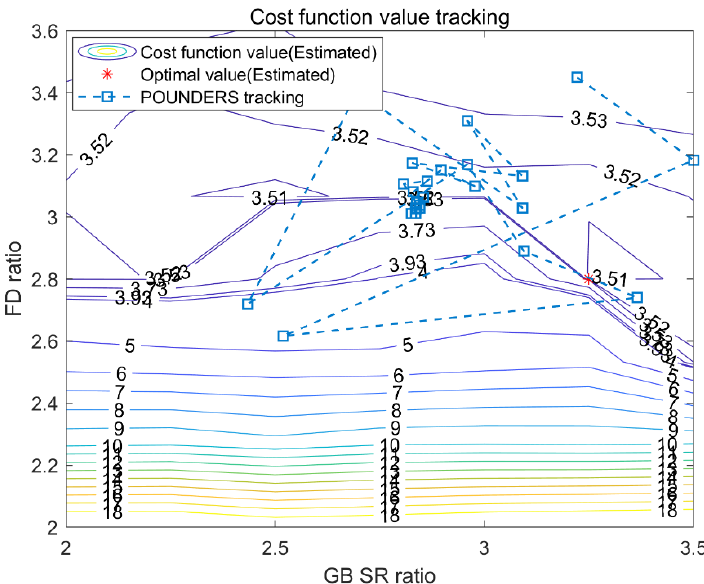
Figure 8. Cost function value contour and parameter optimization history versus GB and FD.